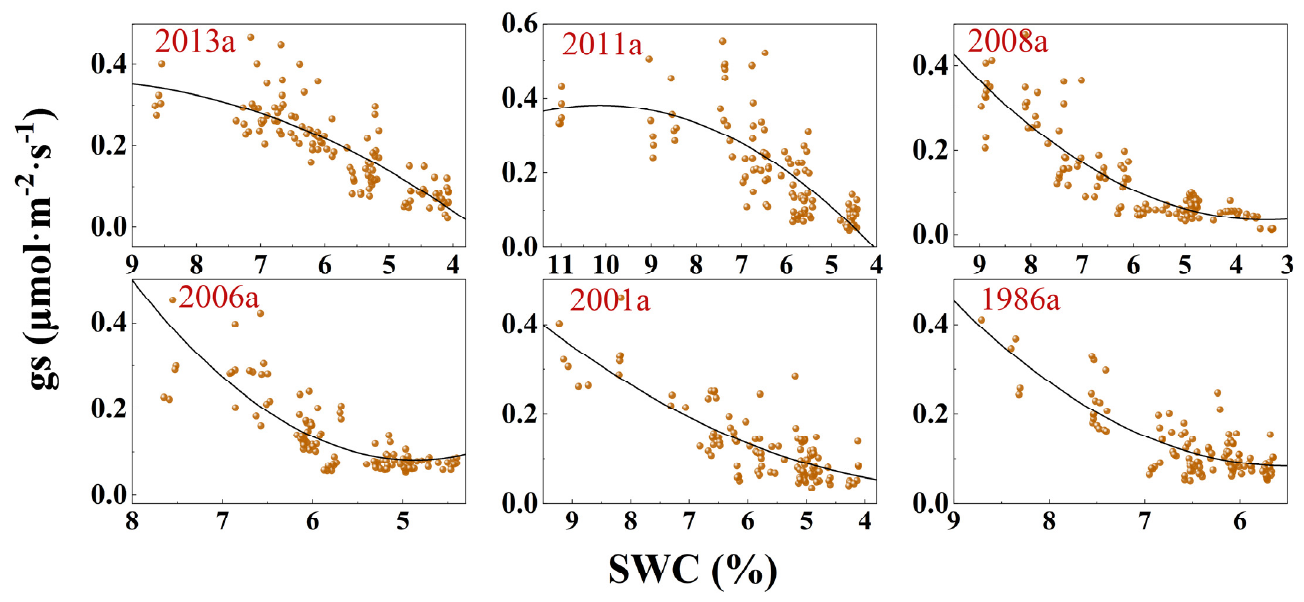
Figure 3. Regression fi tt ing diagram of Pn and SWC.